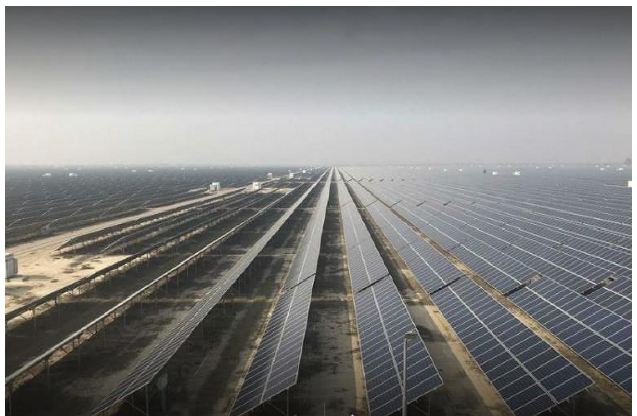
Fig. 8. QASPP PV area inter array spacing